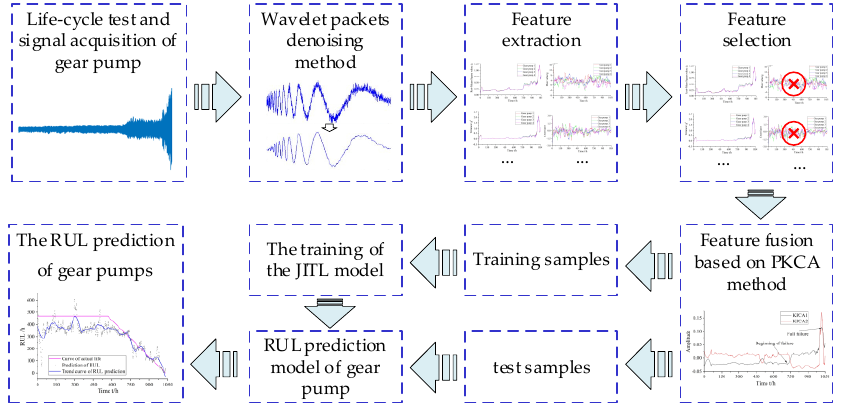
Figure 1. The RUL prediction process of gear pump.